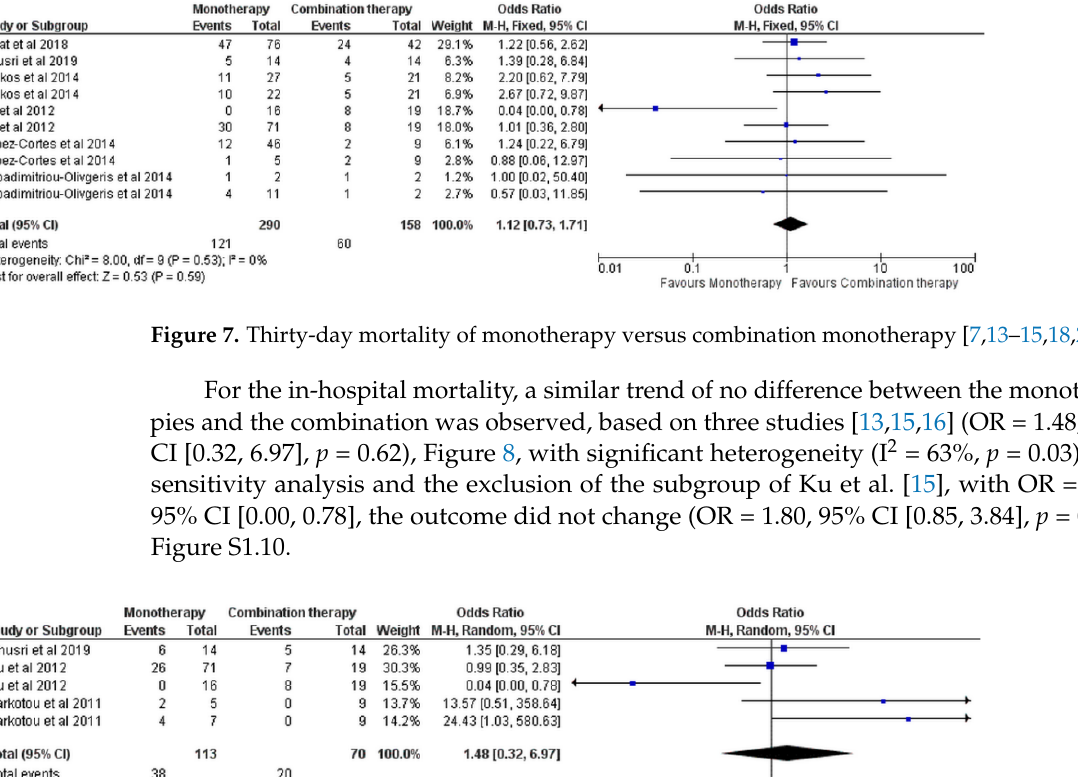
Figure 8. In-hospital mortality of monotherapy versus combination monotherapy [13,15,16].